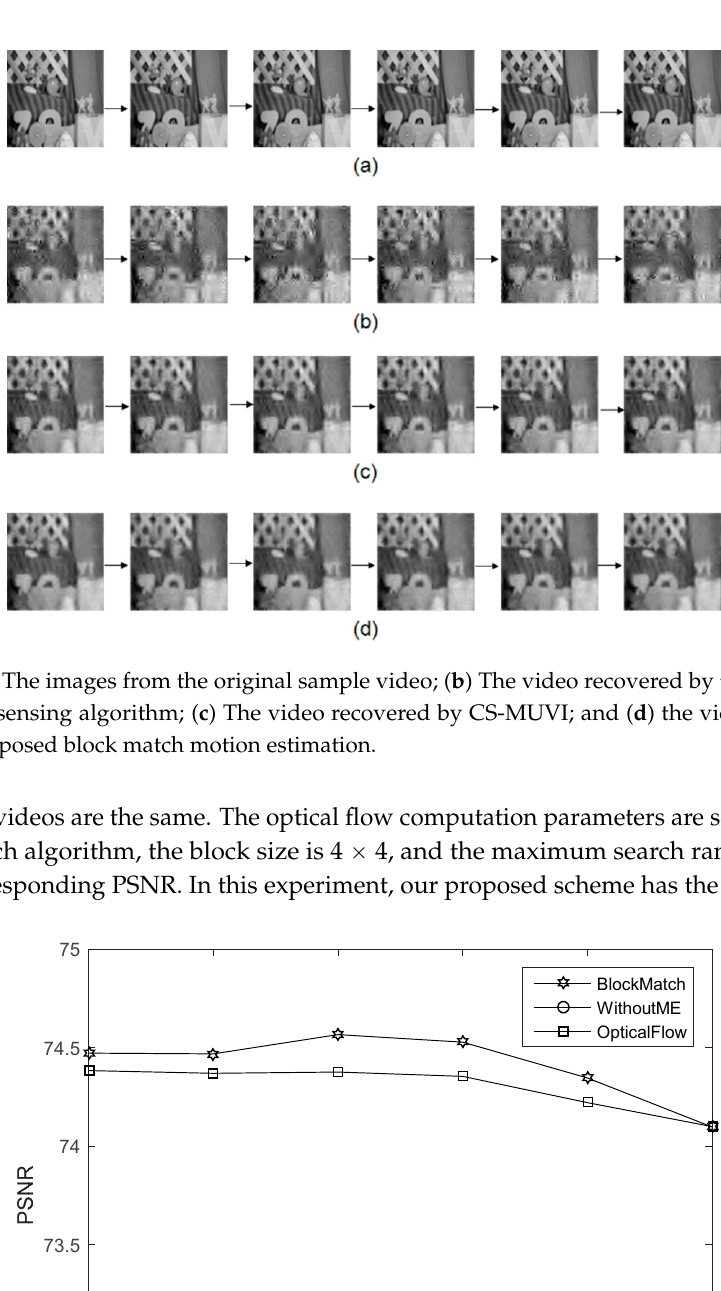
Figure 11. PSNR of the images reovered by our block matching scheme, the optical flow and without motion estimation (WithoutME).